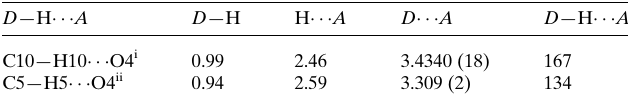
Table 1 Hydrogen-bond geometry (A˚ , (cid:2) ).